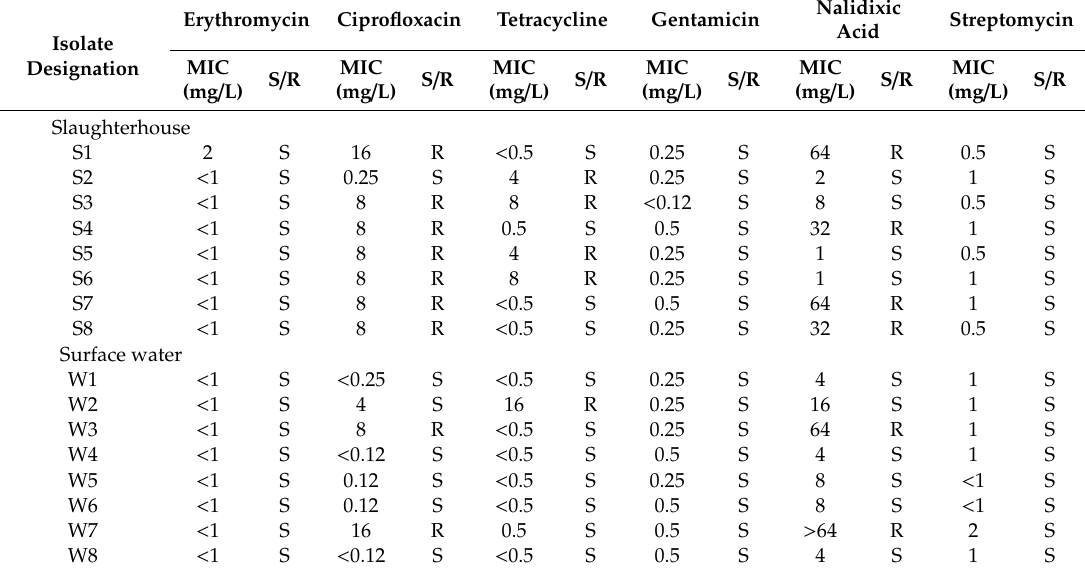
Table 1. Susceptibilities of the individual Campylobacter jejuni slaughterhouse and surface-water isolates to the tested